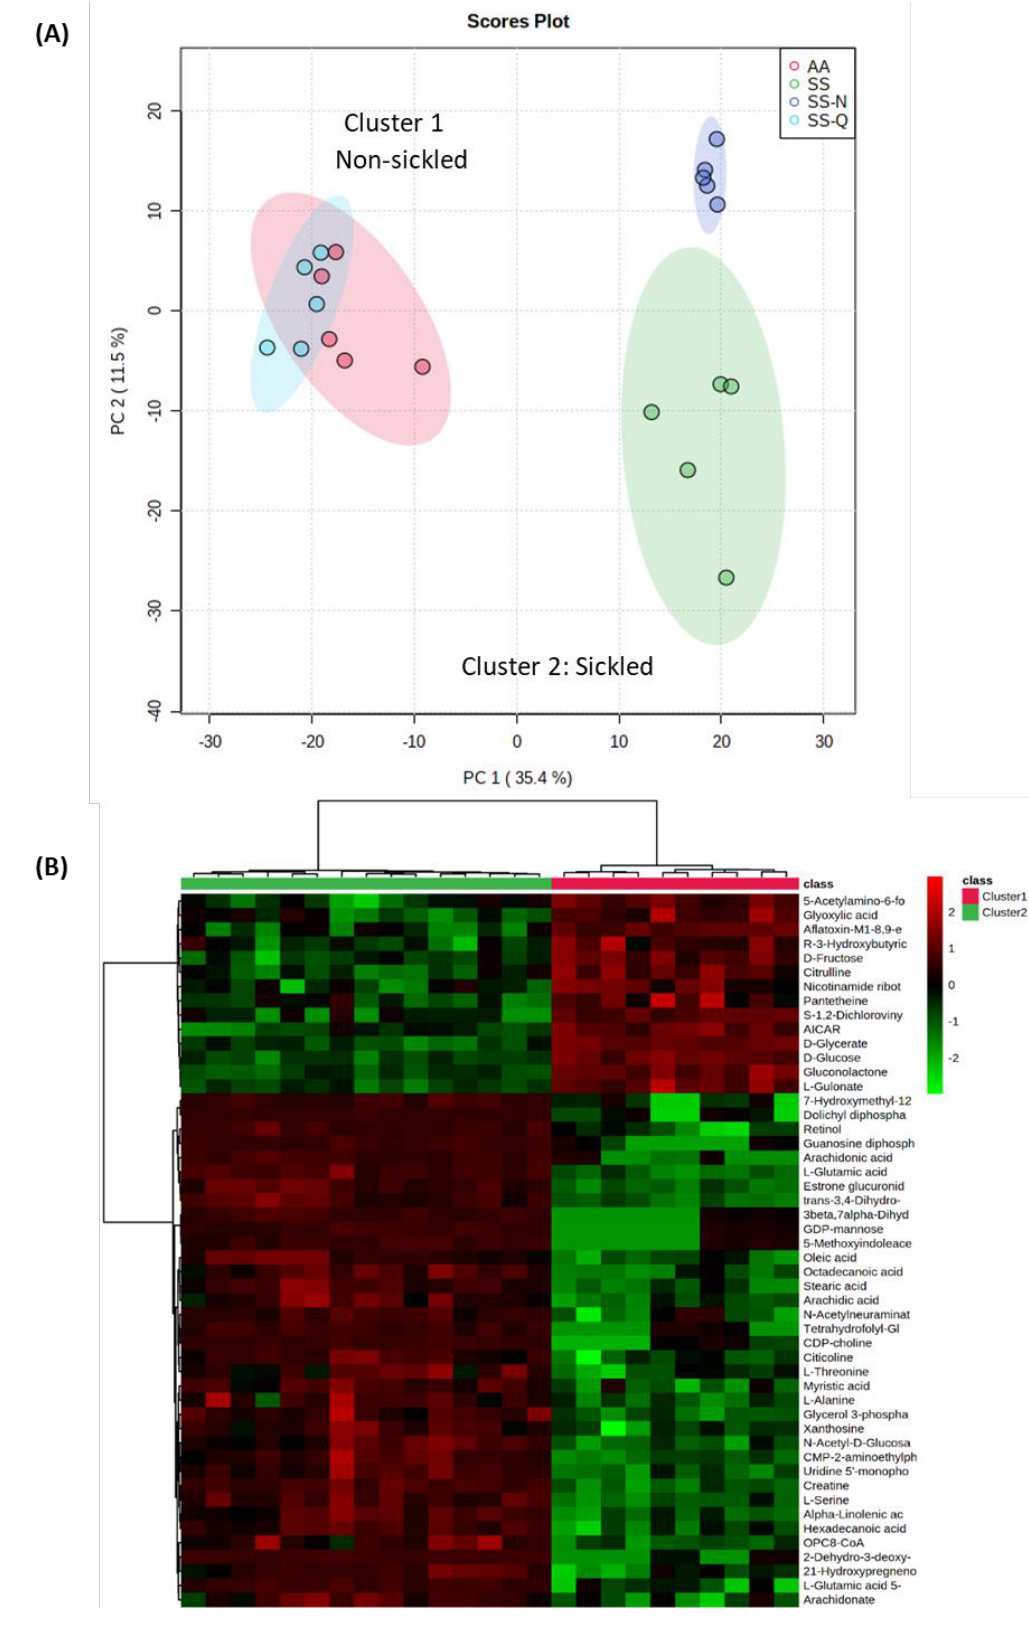
Figure 6. The metabolomic impact of quercitrin on erythrocyte sickling shown using ( A ) Principal component analysis (PCA and ( B ) hierarchical cluster analysis highlighting the major sources of variation between cluster 1 and cluster 2 on the PCA.